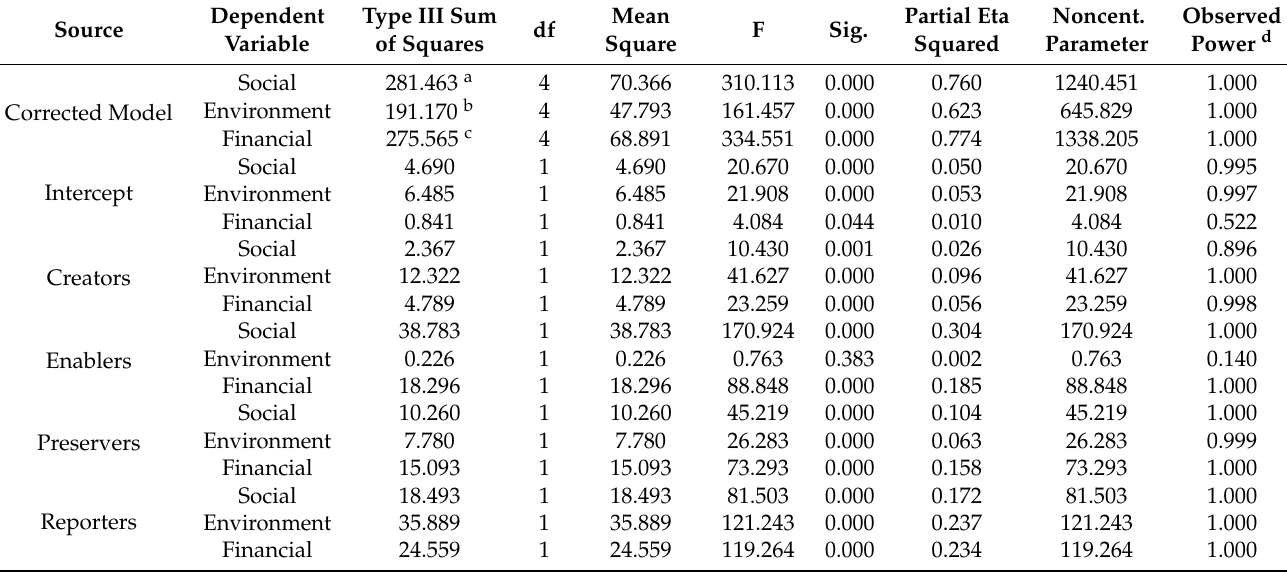
Table 5. Tests of between-subject